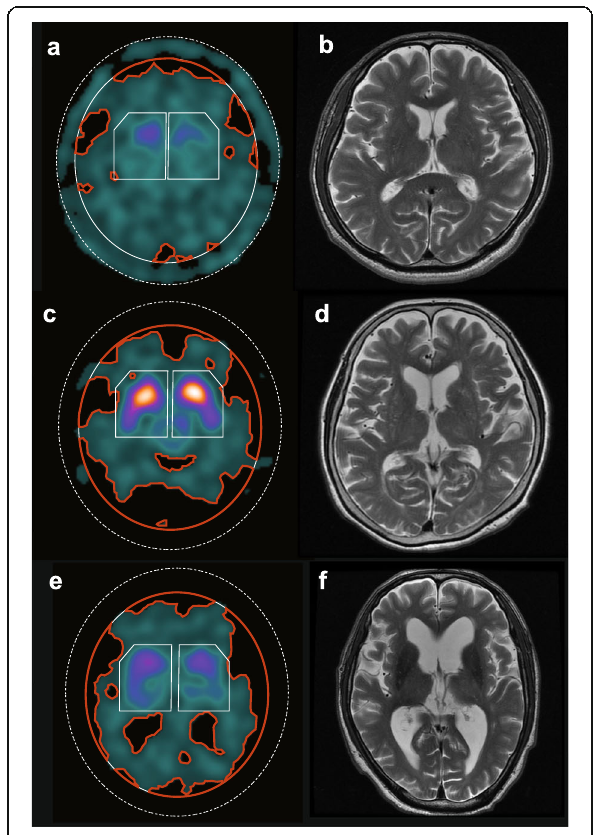
Fig. 5 DAT SPECT ( a , c , e ) and MRI ( b , d , f ) images of representative cases of the low, middle, and high EI groups. a and b A resprentative case of the low EI group (age 66, male, EI = 0.217). c and d A representative case of the middle EI group (age 75, female, EI = 0.279). e and f A representative case of the high EI group (age 75, male, EI =